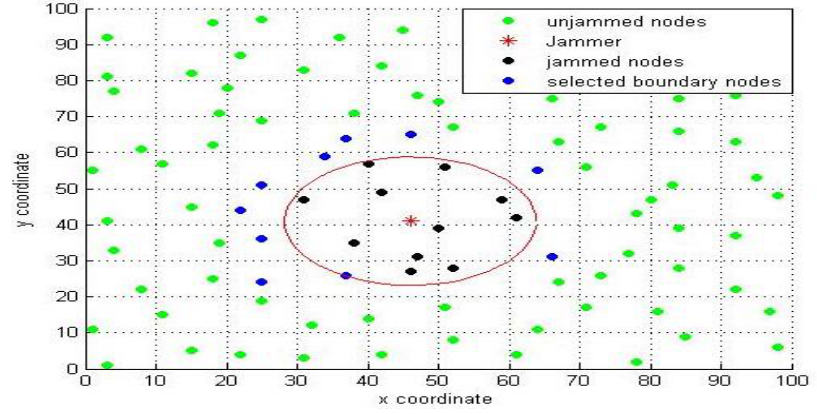
Figure 3. Network deployment.